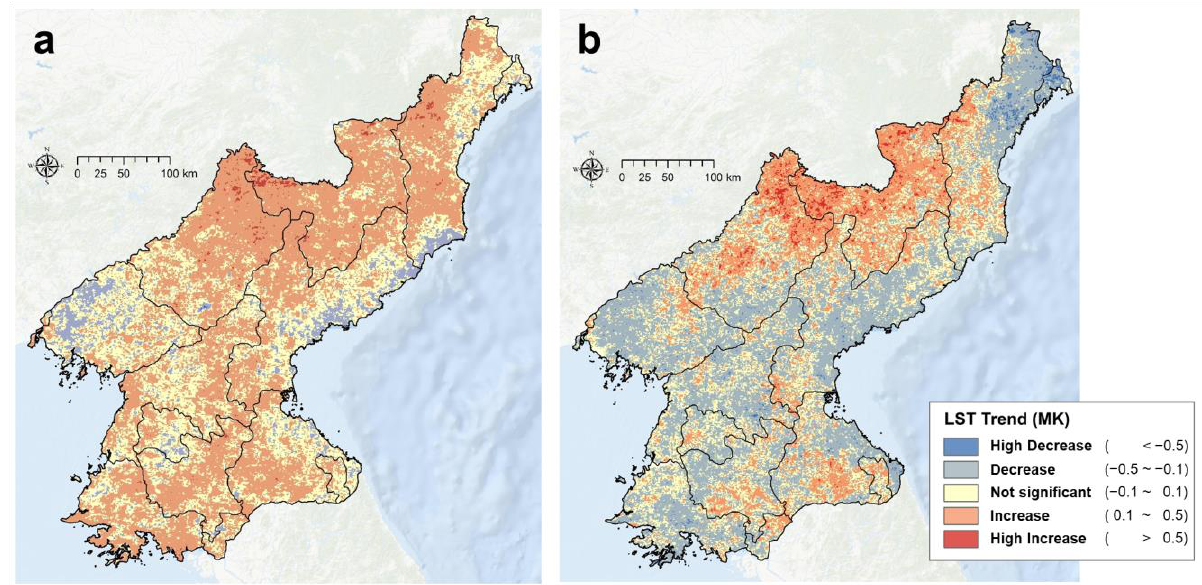
Figure 5. Spatiotemporal trend of land surface temperature in ( a ) 2000 – 2021 and ( b ) 2012 – 2021.